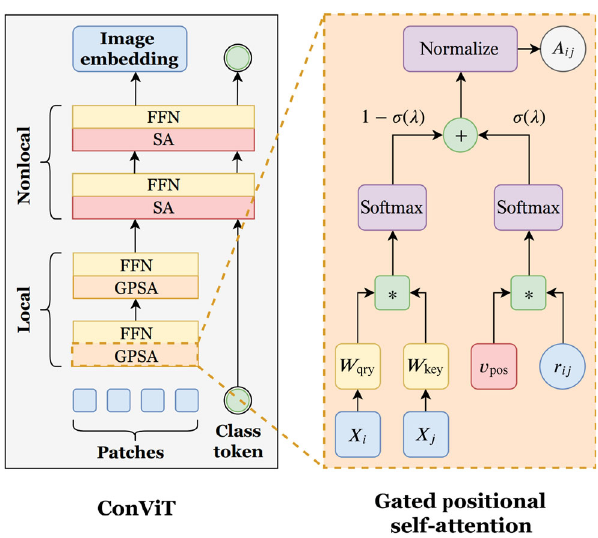
Fig. 4 Framework of ConViT and the gated positional self-attention mechanism. Reproduced with permission from Ref. [18], c (cid:2) The Author(s)